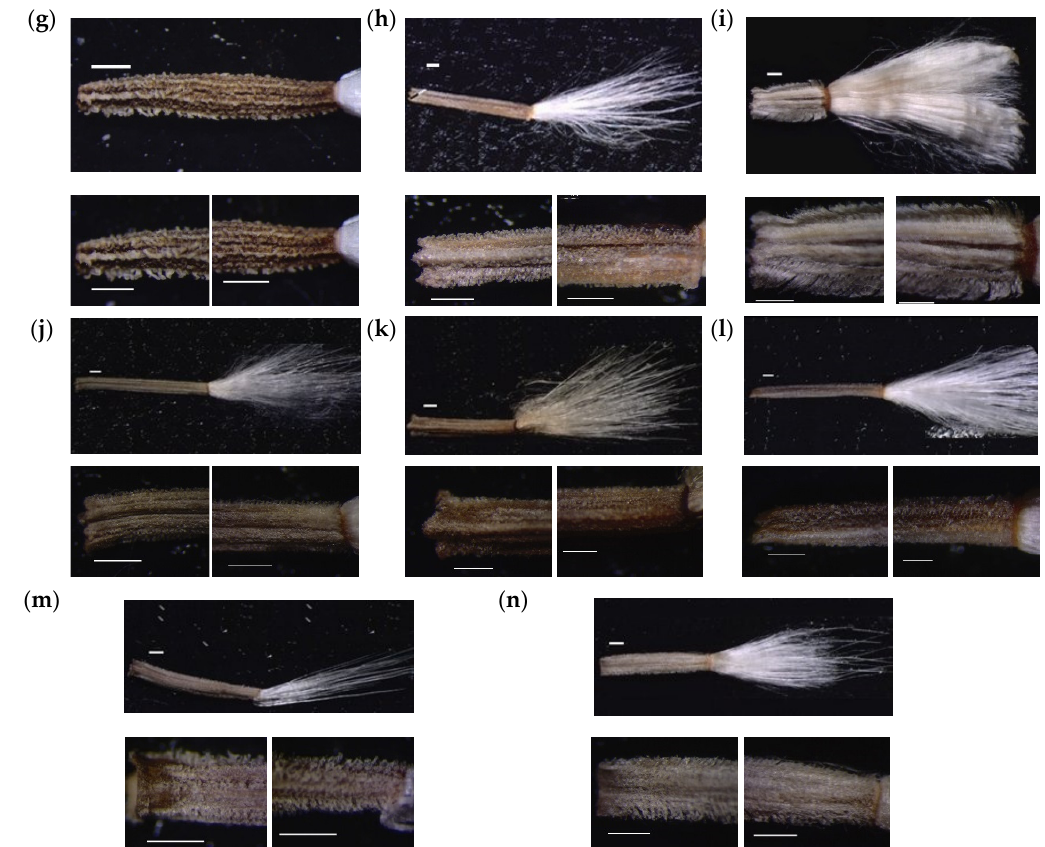
Figure 2. Stereomicrographs of marginal achenes shape (upper), base (lower left) and apex (lower right). ( a ) Reichardia tingitana , obcolumnar, truncate base and apex. ( b – n ) Launaea : ( b ) L. spinosa , subcuneate, truncate base and apex; ( c ) L. capitata , winged-cylindrical, truncate base and apex; ( d ) L. intybacea and ( e ) L. massauensis , beaked-subfusiform, truncate base, rostrate apex; ( f ) L. nudicaulis , subcuneate, truncate base and apex; ( g ) L. nudicaulis (specimen 33), subfusiform, truncate base and apex; ( h ) L. angustifolia subsp. angustifolia , cylindrical, horned base, truncate apex; ( i ) L. angustifolia subsp. arabica , cylindrical, horned base, truncate apex; ( j – l ) L. fragilis subsp. fragili s: ( j ) cylindrical (specimens 129) or ( k ) columnar (specimens 72) or ( l ) obcolumnar (specimens 102), horned base, truncate apex; ( m , n ) L. mucronata : ( m ) subsp. cassiniana and ( n ) subsp. mucronata , columnar, truncate base and apex. Scale bar = 0.5 mm.